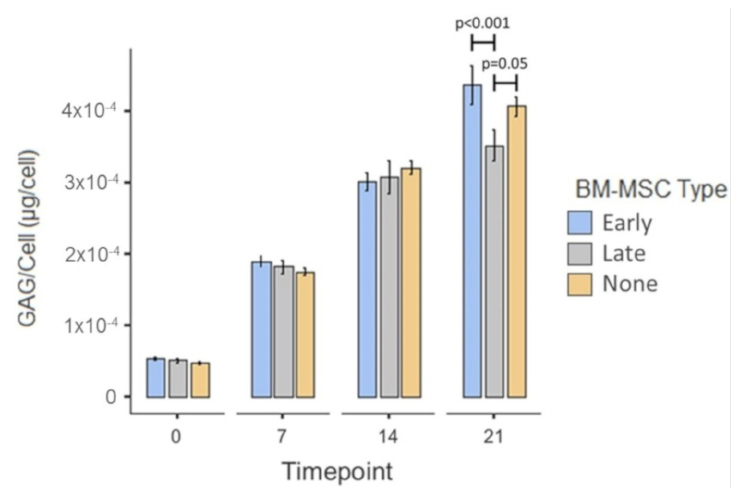
Figure 10. Mean GAG/chondrocyte of the scaffolds taken from the co-culture model at the four timepoints. Error bars represent the standard error of the mean. Significant differences are indicated by horizontal bars.